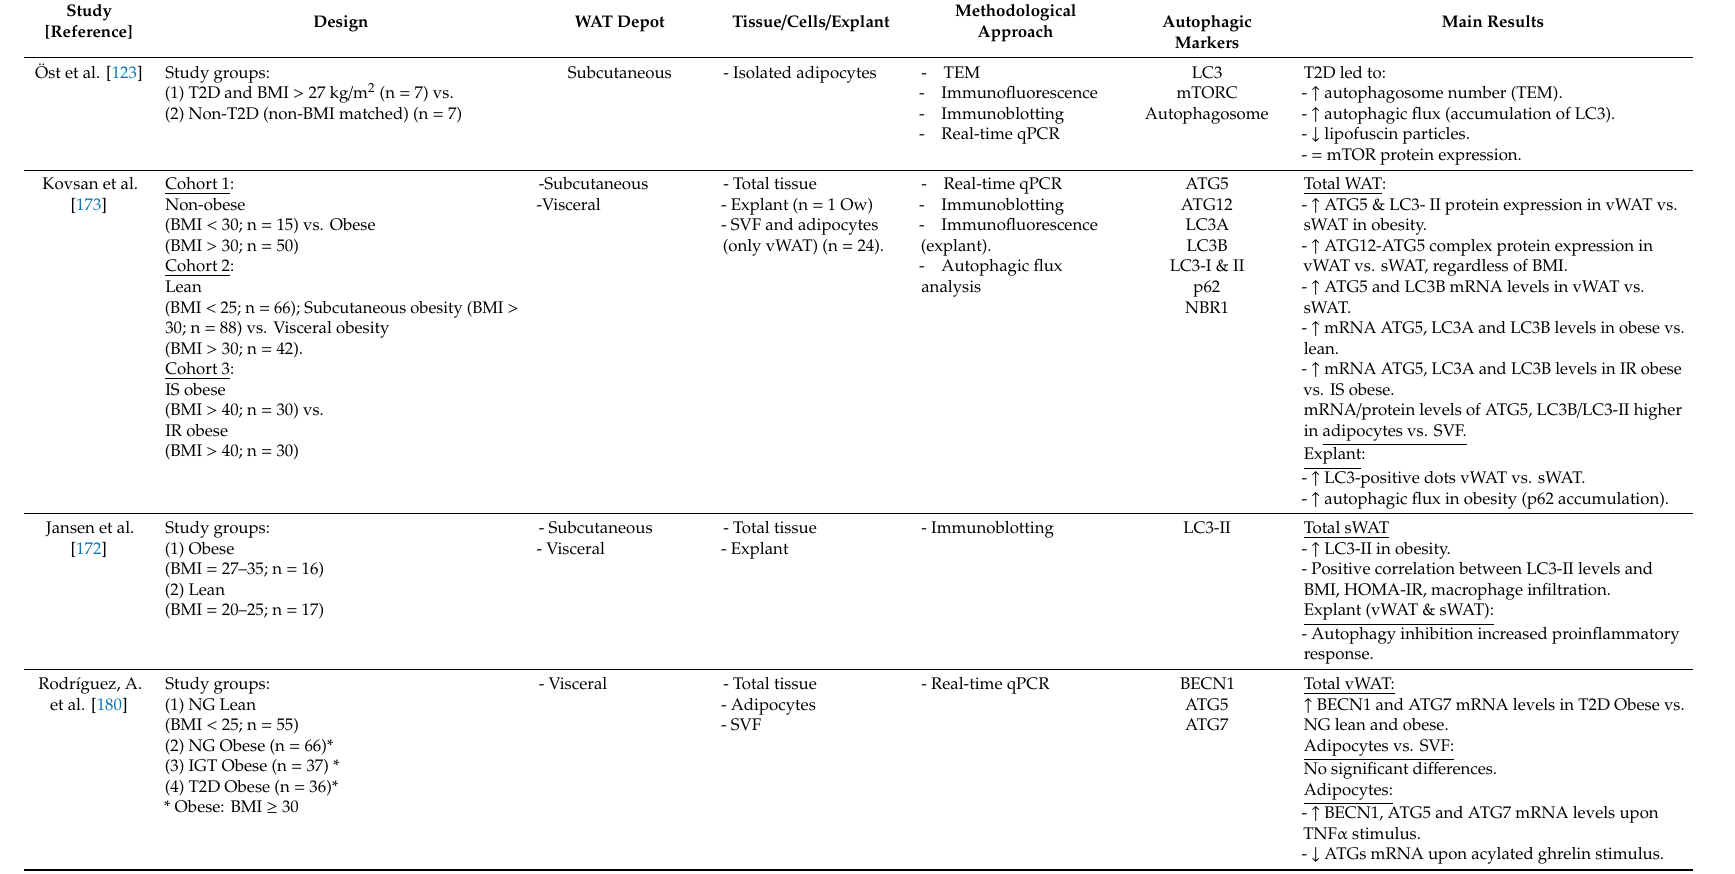
Table 1. Human studies analyzing autophagy state in obesity and / or